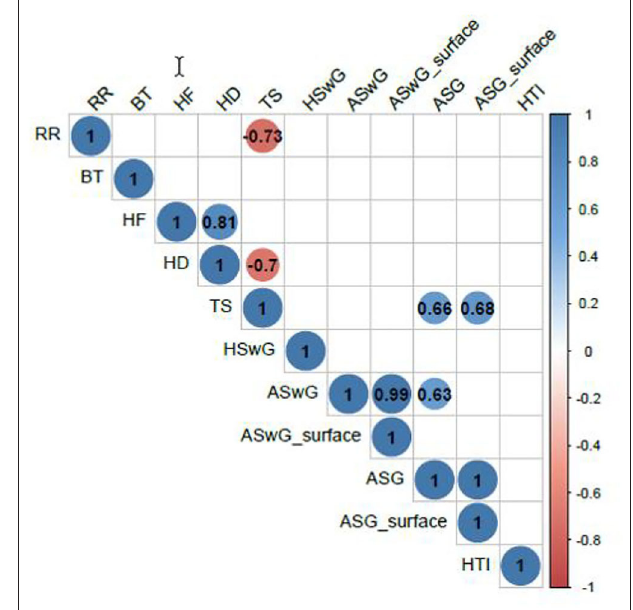
histomorphometric variables number of HF, hair density (HD), TS, HSwG, ASwG, ASwG_surface, ASG, and ASG_surface of adult female buffaloes reared in humid tropical